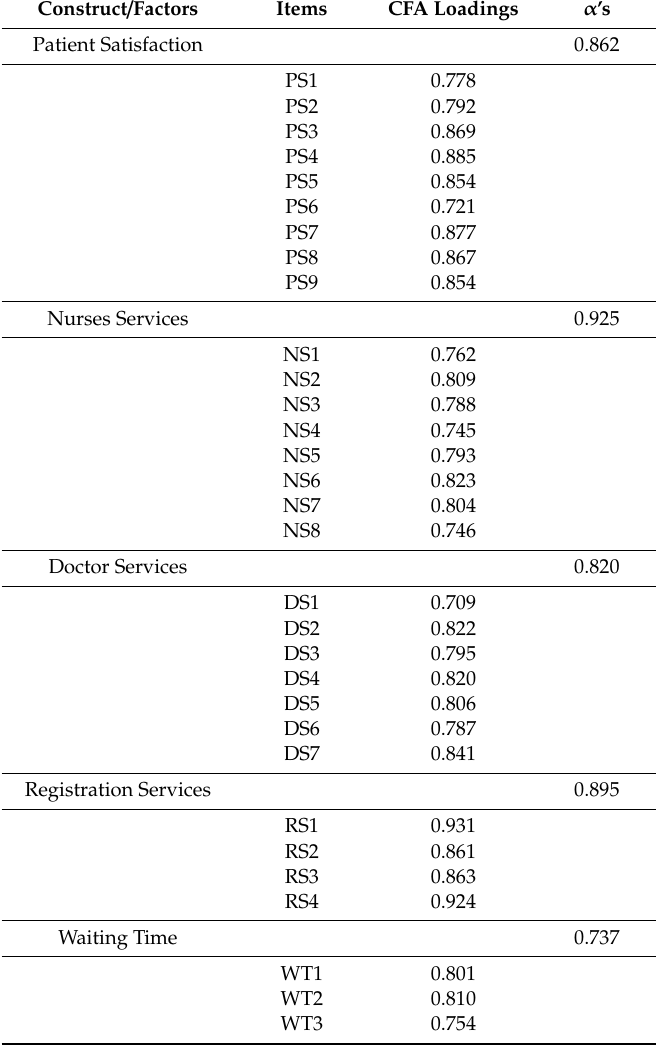
Table 3. Results of the confirmatory factor